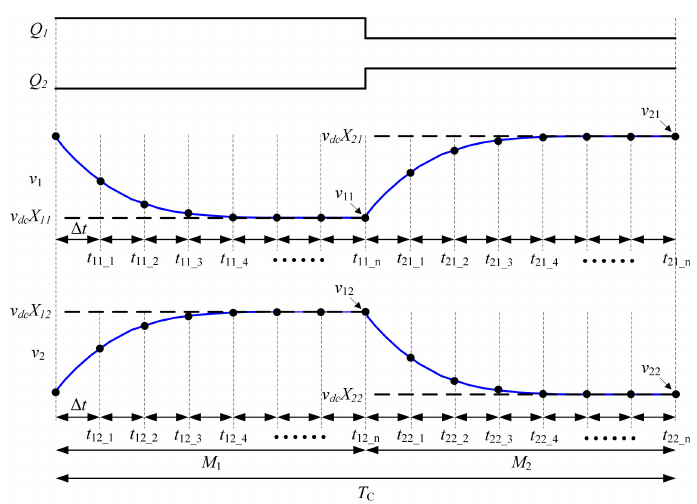
Figure 3. Traditional sampling